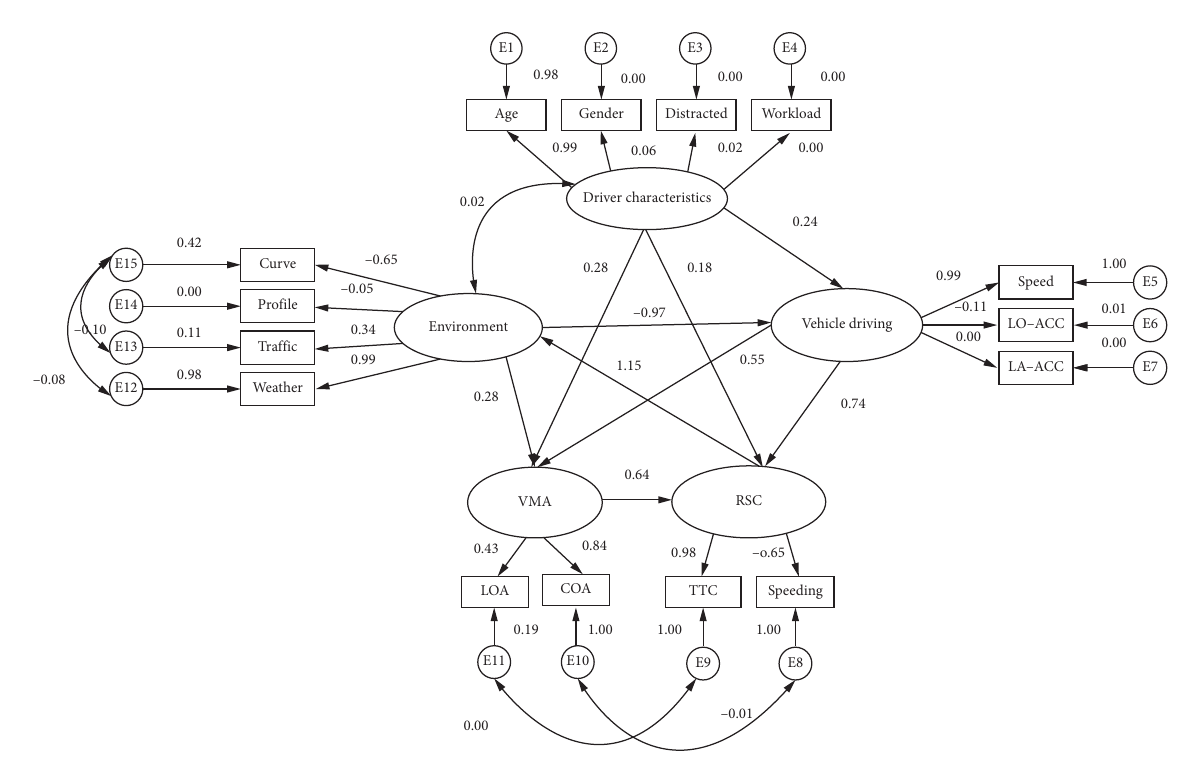
Figure 5: SEM of the relationship between driver characteristics and driving safety. Table 6: Value of fit